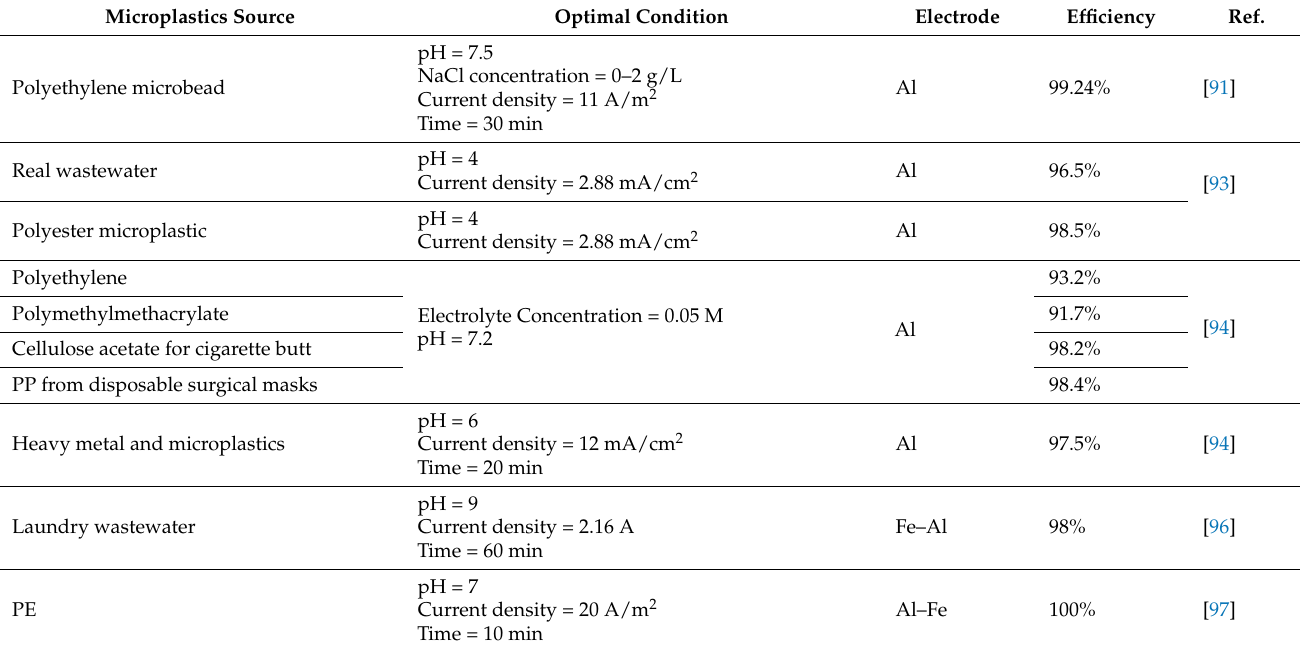
Table 3. Outcome of different experiments for separation of microplastics using electrocoagulation.